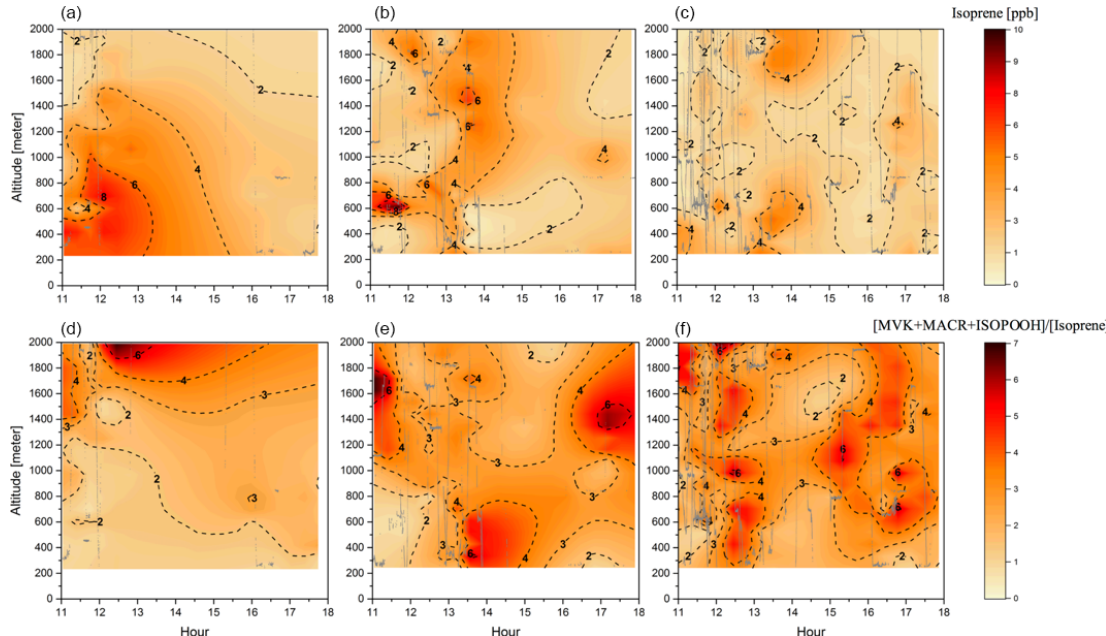
Figure 5. Cross section of the isoprene mixing ratio (ppbv) (a–c) and the [MVK + MACR + ISOPOOH] / [isoprene] ratio (d–f) for the three different groups: background environment (on the left), fresh smoke plume ( t <2h, in the middle), and aged smoke plume ( t >2h, on the right). The aircraft data were interpolated from the various vertical profile measurements using the kriging correlation method (Supplement Fig. S1). White dashed lines show the flight tracks. Hour units are presented in local